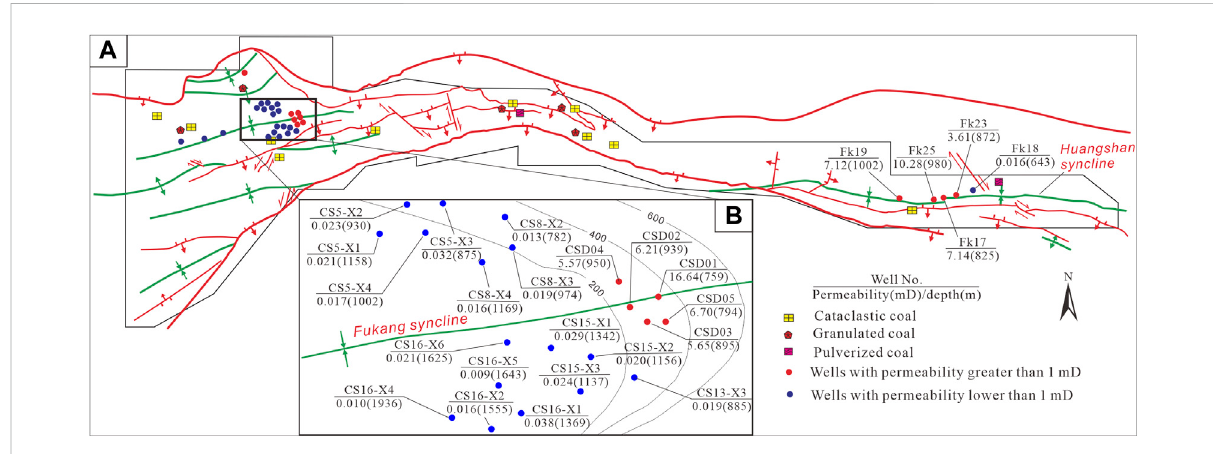
FIGURE 14 (A) Diagram showing distribution of deformed coals and measured permeability of Coal B42 from coalbed methane wells. (B) Enlargement of diagram (A) at the core part of the Fukang